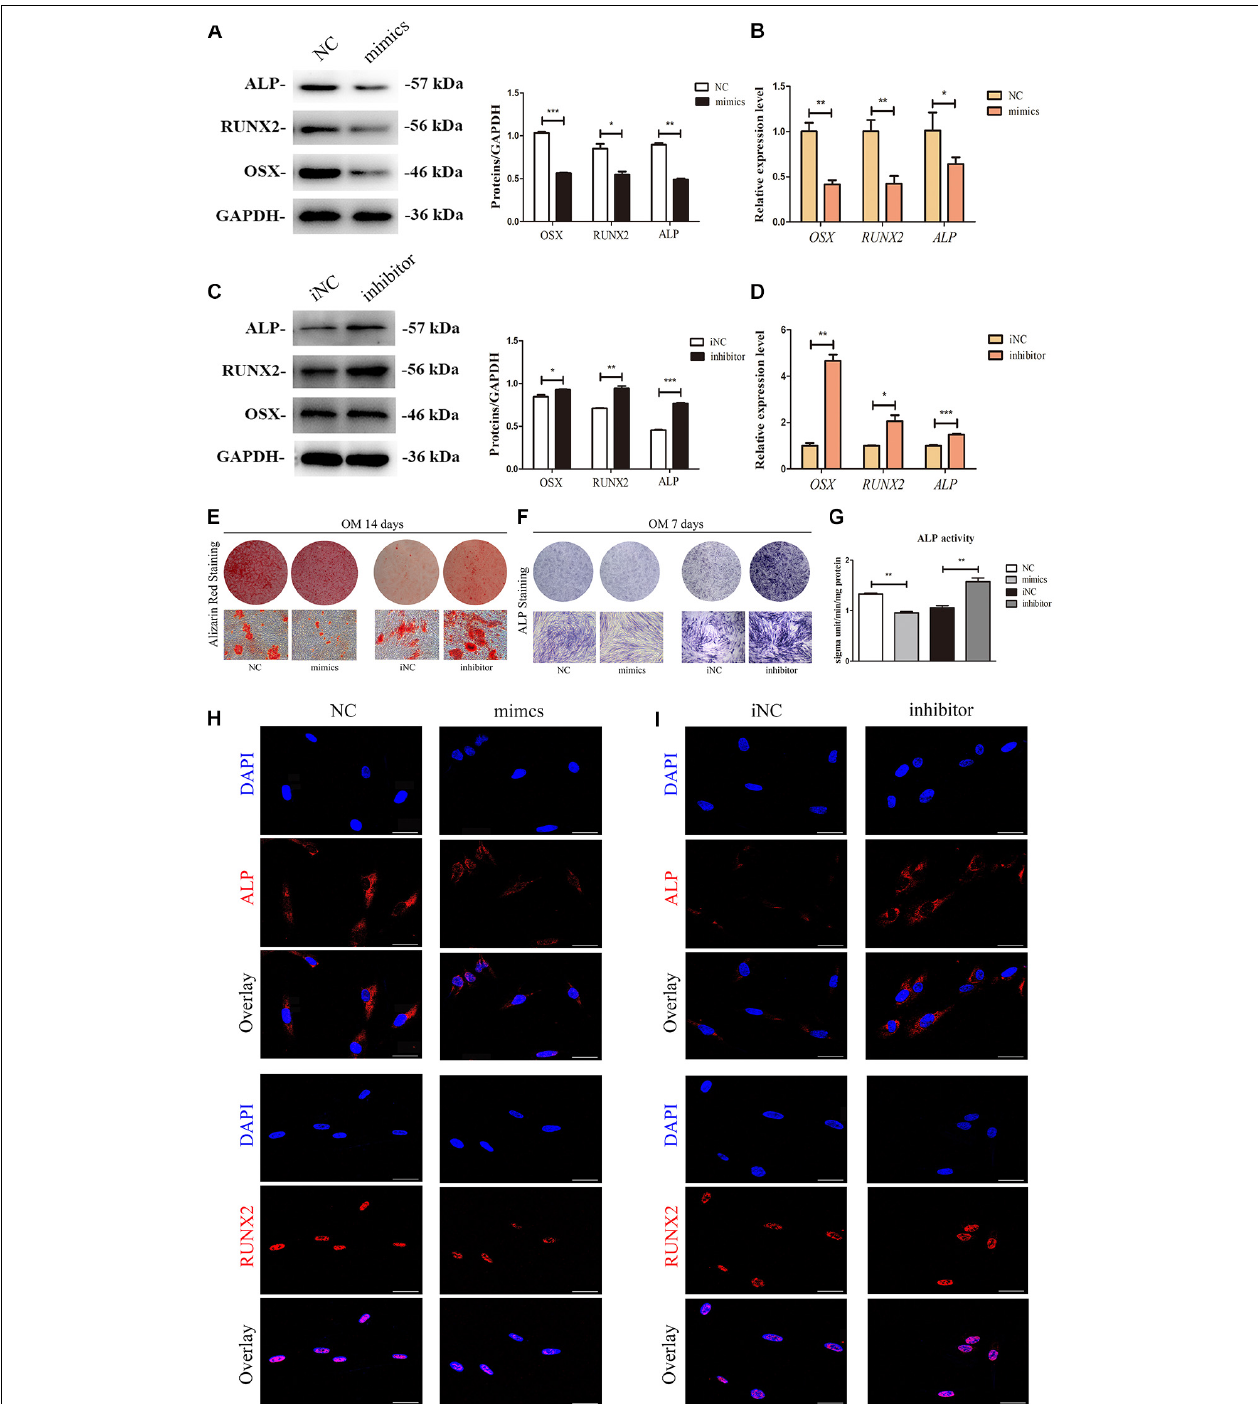
FIGURE 5 | MiR-7-5p participates in osteogenic differentiation of iPDLSCs. (A) Western blot assay showed higher protein levels of ALP, RUNX2, and OSX in mimics group than the control group. GAPDH was the internal control. (B) qRT-PCR analysis of RUNX2, OSX, and ALP levels of iPDLSCs in control group and mimics group. (C) Western blot assay showed lower protein levels of ALP, RUNX2, and OSX in inhibitor group than the control group. GAPDH was the internal control. (D) qRT-PCR analysis of RUNX2, OSX, and ALP levels of iPDLSCs in control group and inhibitor group. (E) After 14 days of culture, Alizarin red staining showed more calcified nodules in the mimics NC group than mimics group and less calcified nodules in the inhibitor NC group than inhibitor group. (F,G) The ALP staining assay and ALP activity at Day 7 in the NC group, mimics group, iNC group and inhibitor group. (H,I) Immunofluorescence assay revealed downregulated ALP and RUNX2 in mimics group compared with NC group and upregulated ALP and RUNX2 in inhibitor group than iNC group. Scale bar = 100 µ m (* P < 0.05, ** P < 0.01, *** P < 0.001).